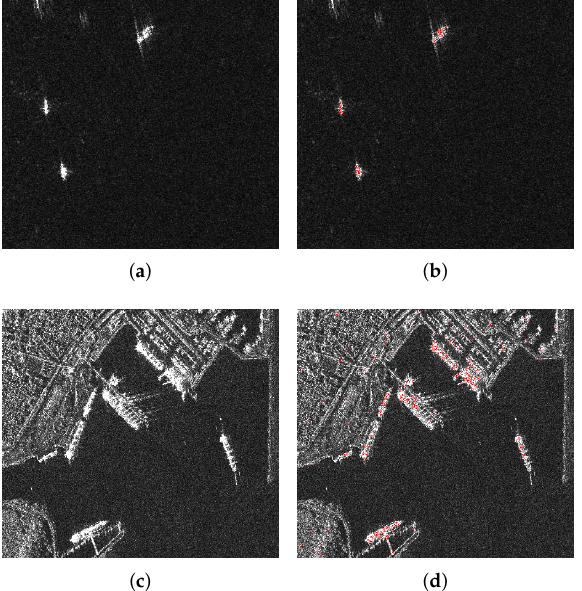
Figure 9. Display of partial clustering results on pictures. Ships from clustering are in red. ( a ) Original image of ships on the sea. ( b ) Clustering results for the ships on the sea. ( c ) Original image of ships near the shore. ( d ) Clustering results for the ships near the